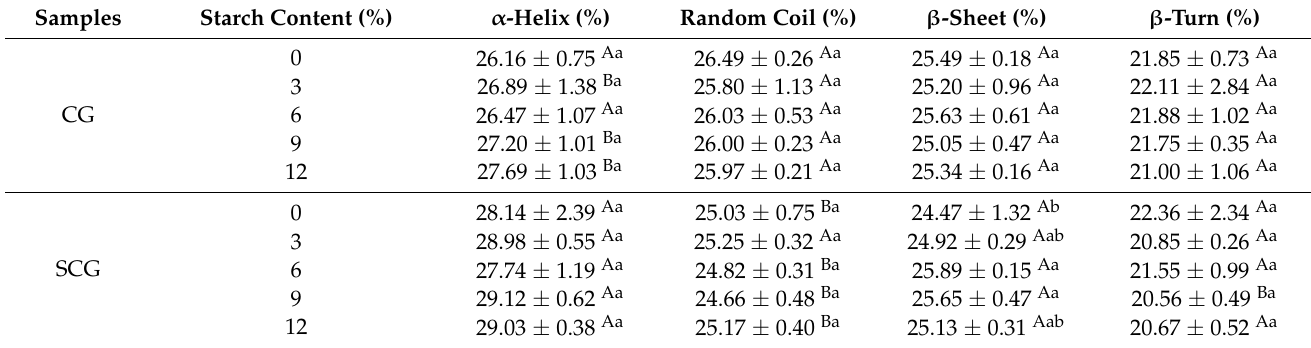
Table 3. Secondary structure (amide I) of protein in different starch–surimi